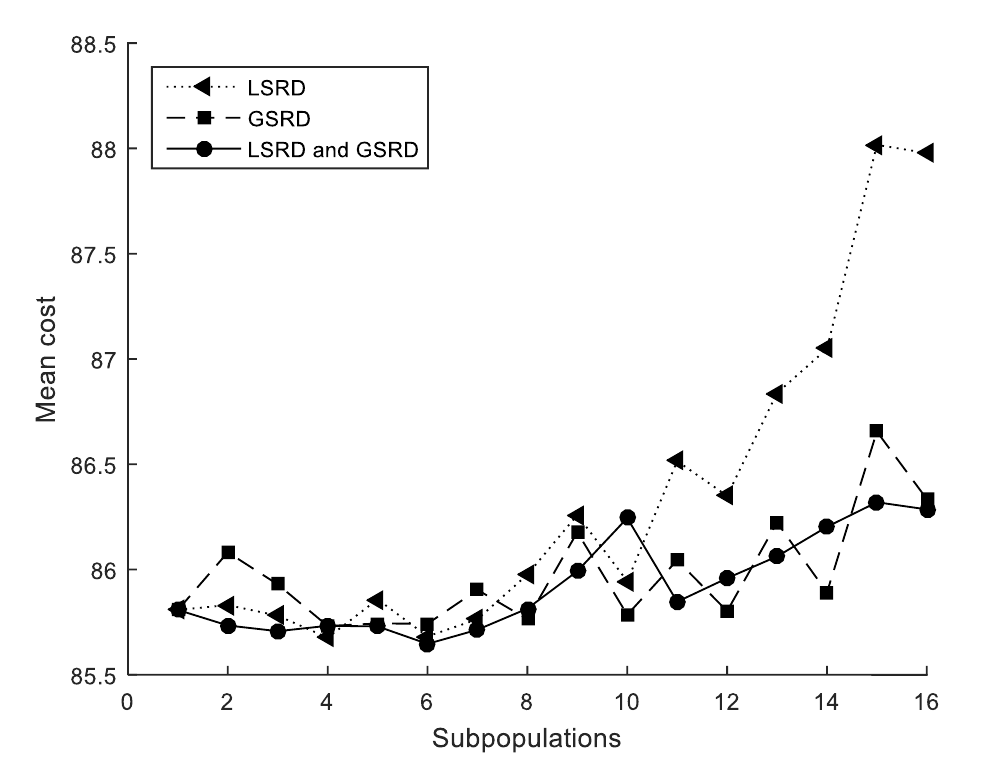
Figure 5. Cross-section under flexure. Mean cost.